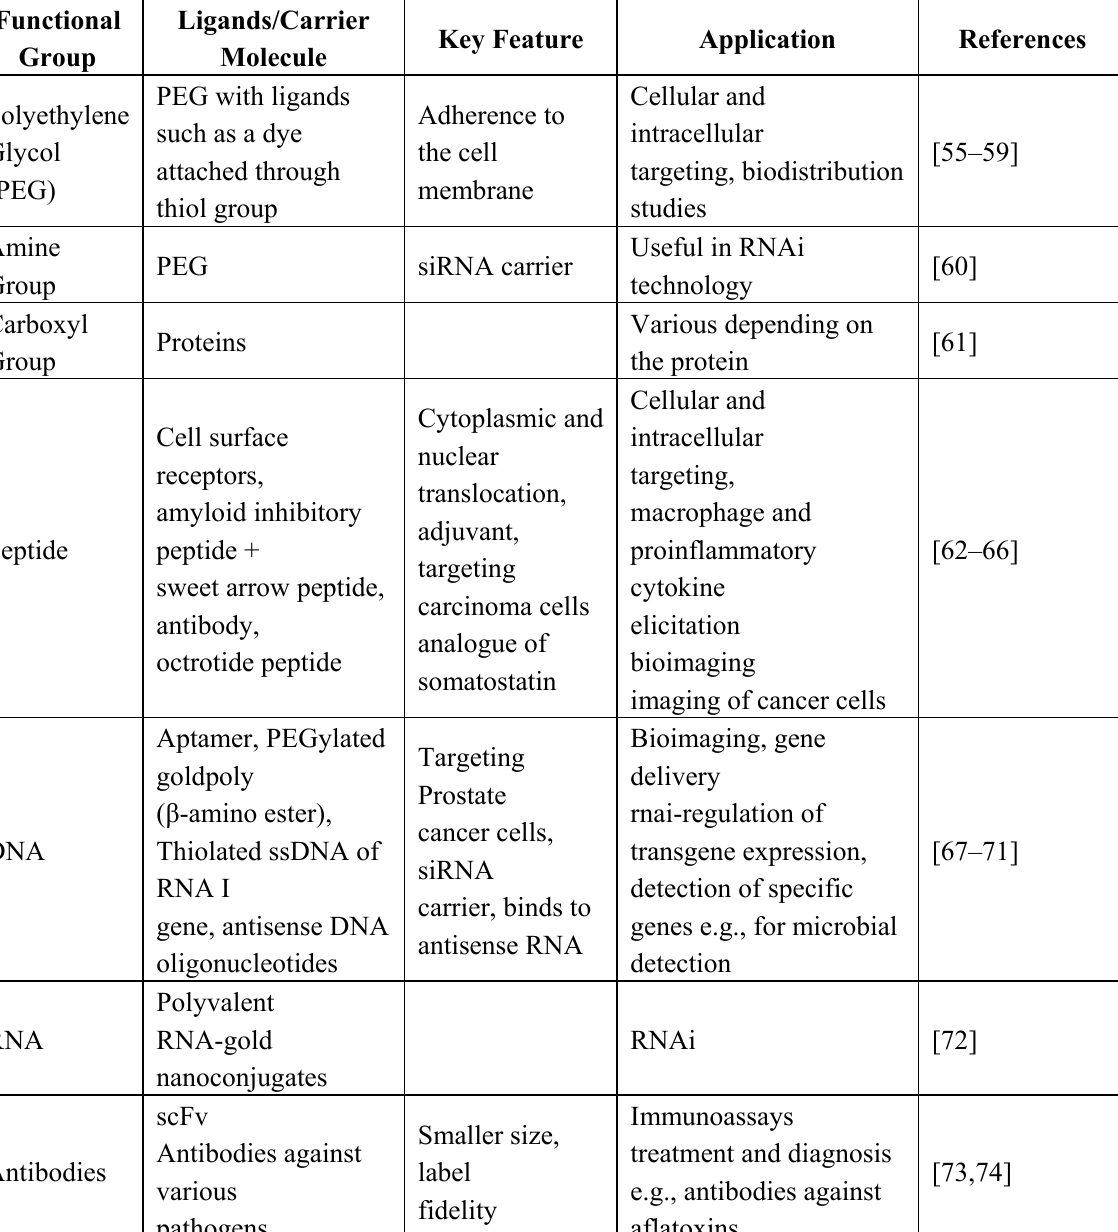
Table 2. Summary of common functionalization of AuNPs and their applications